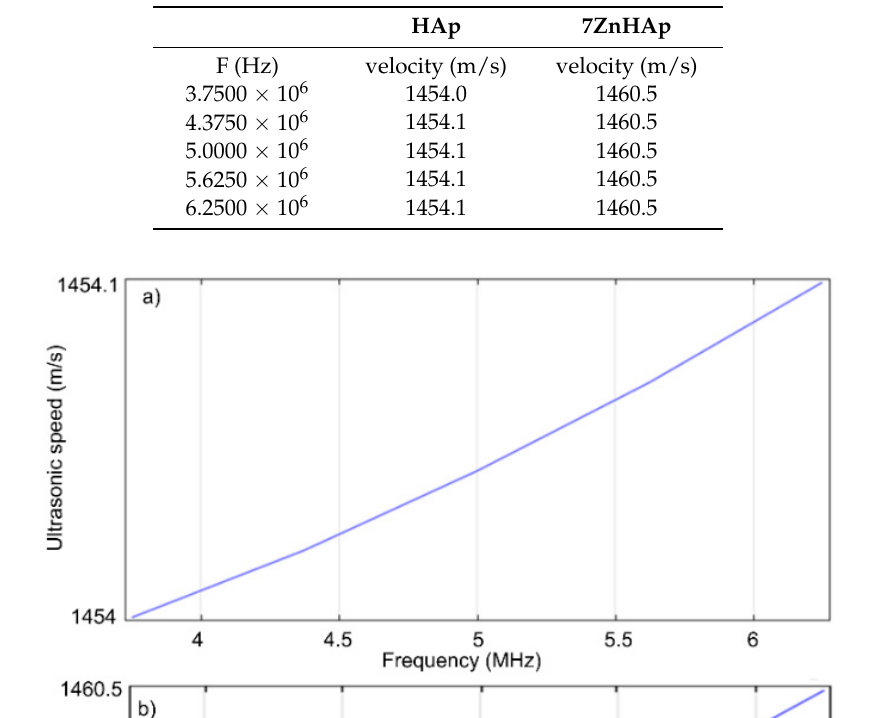
(solid phase: E = 2 Gpa, ν = 0.3, volumetric ratio in water 5%, R = 4.98 nm).